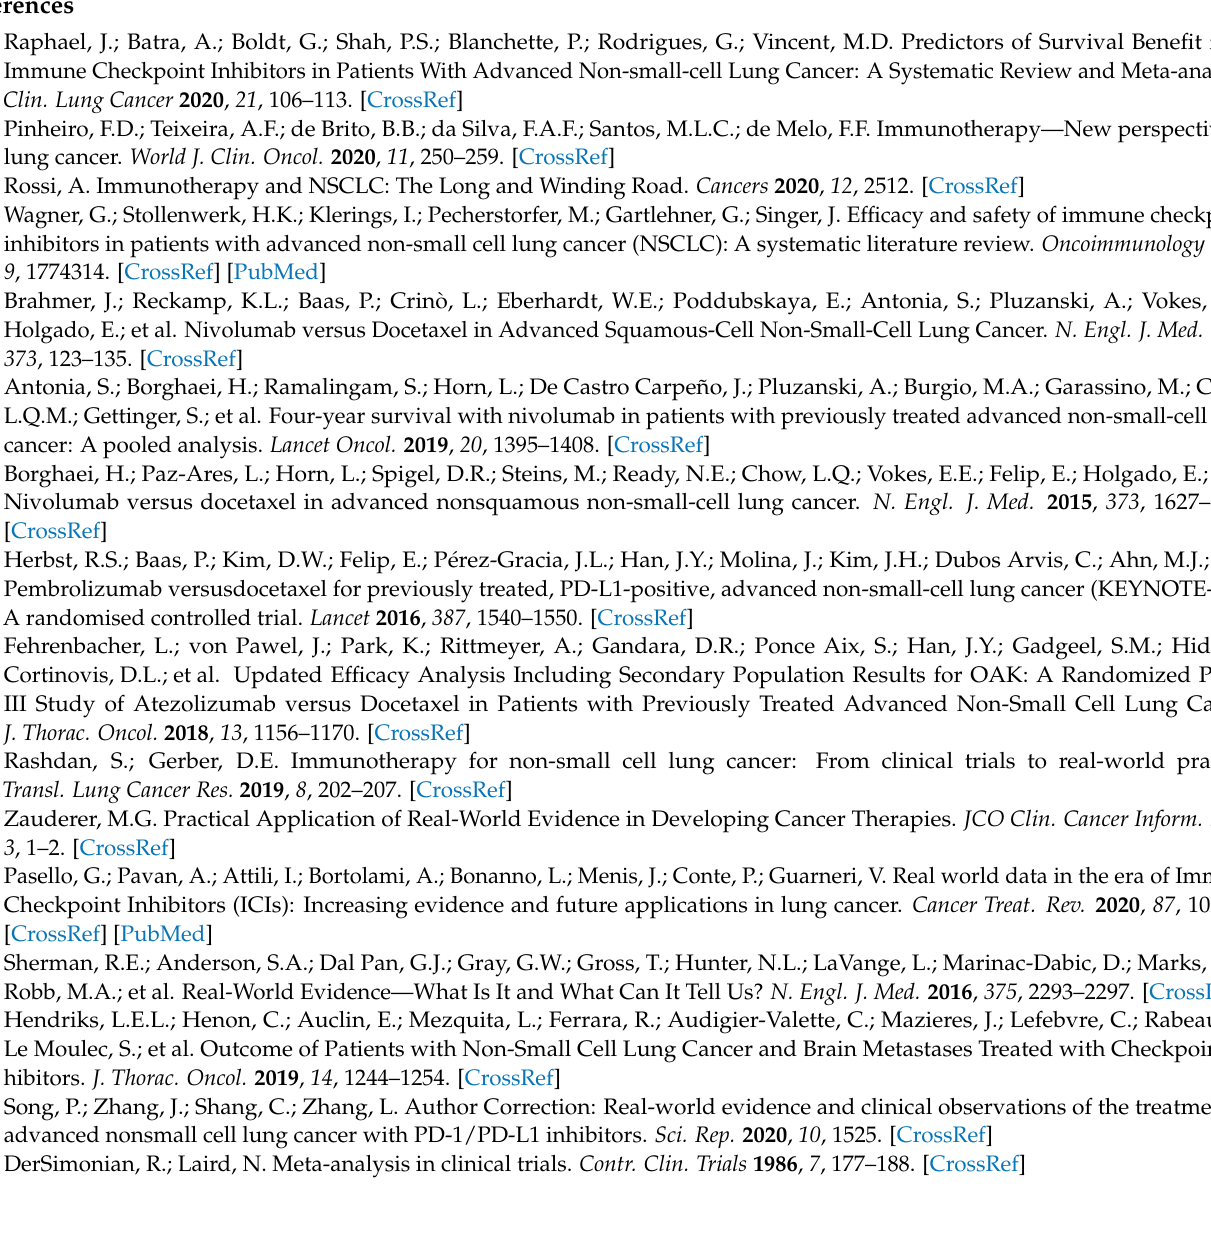
Table S2: Risk of bias according to the Study Quality Assessment Tools for case-series